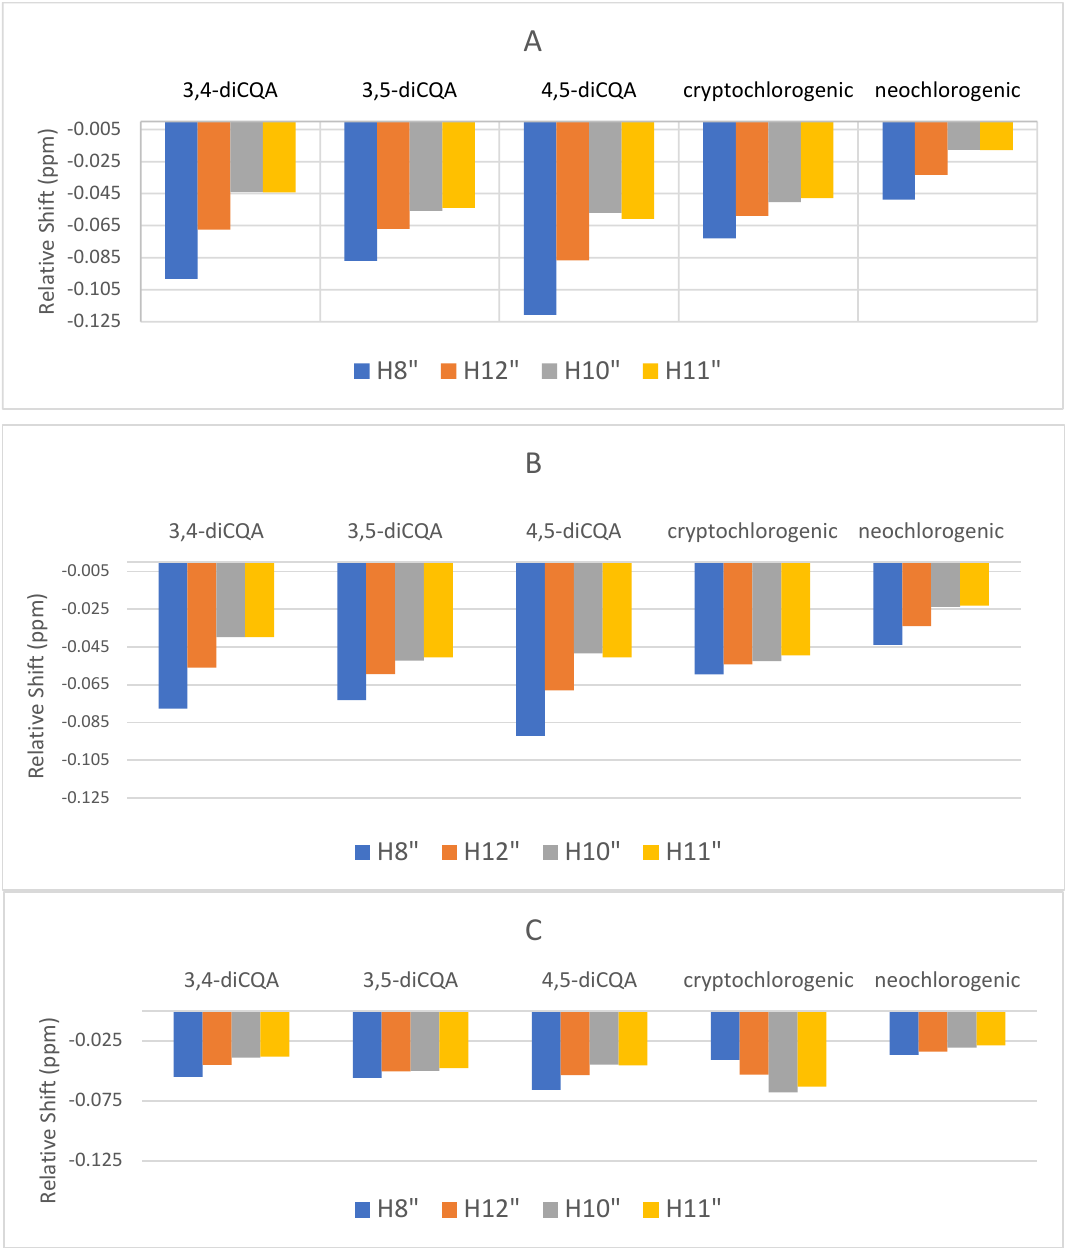
Figure 7. Relative complexation shifts of caffeine 1 H NMR signals with sequential addition of pure caffeine to CQA isomers: ( A ) caffeine (9 mM) and chlorogenic acids (3–10 mM) ( B ) caffeine (27 mM) and chlorogenic acids (3–10 mM) ( C ) caffeine (45 mM) and chlorogenic acids (3–10 mM).